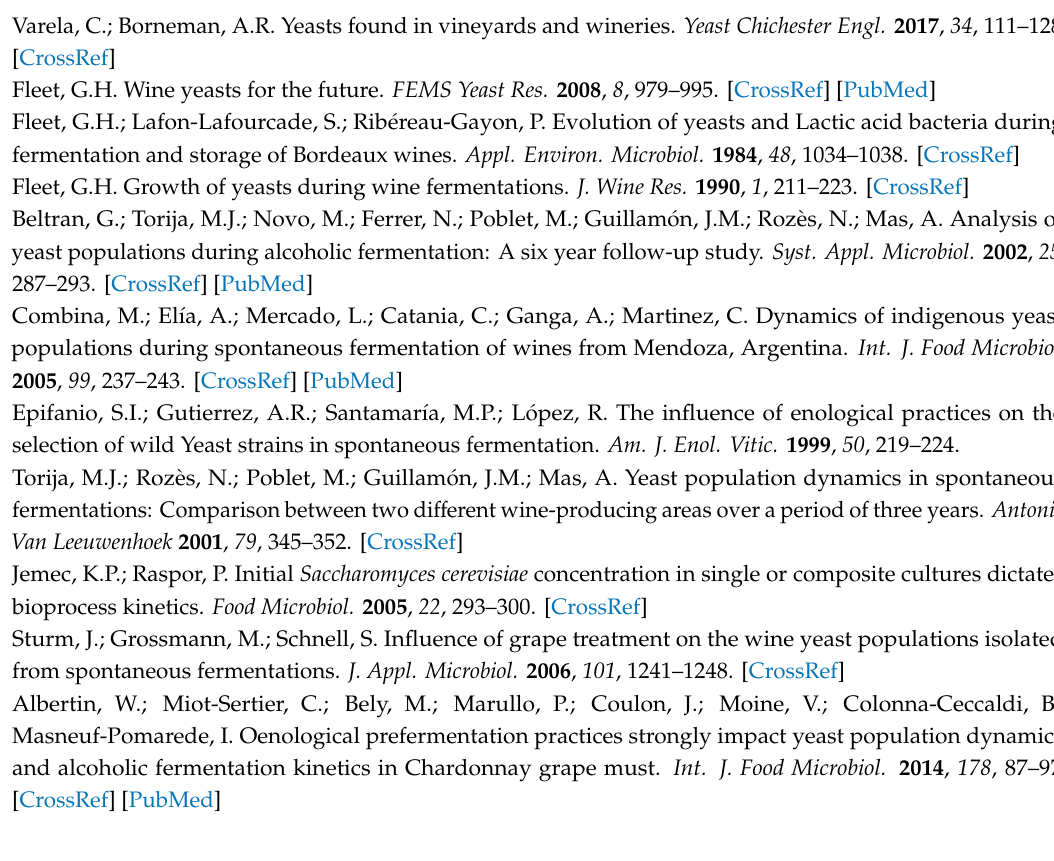
Figure S1: Sugar-consumption kinetics, Figure S2: Replicate fermentation comparisons, Table S1: OTU abundance measurements, Table S2: Chemical analysis